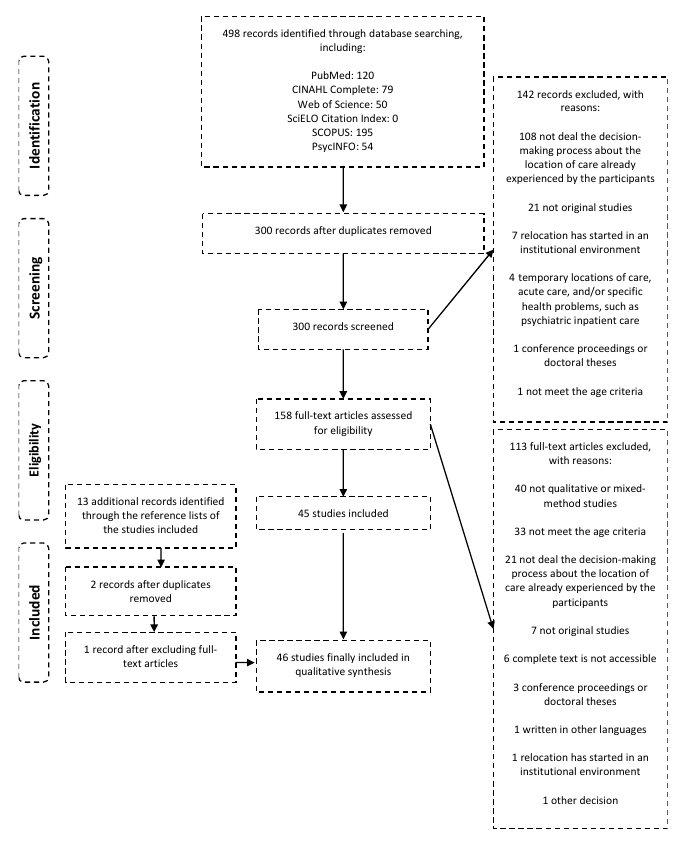
Figure 1. Flow chart (Modified from the Preferred Reporting Items for Systematic Reviews and Meta-Analyses (PRISMA) Flow Diagram [14]). Source: Own elaboration based on the information obtained. More information about the identification in the review protocol [11].